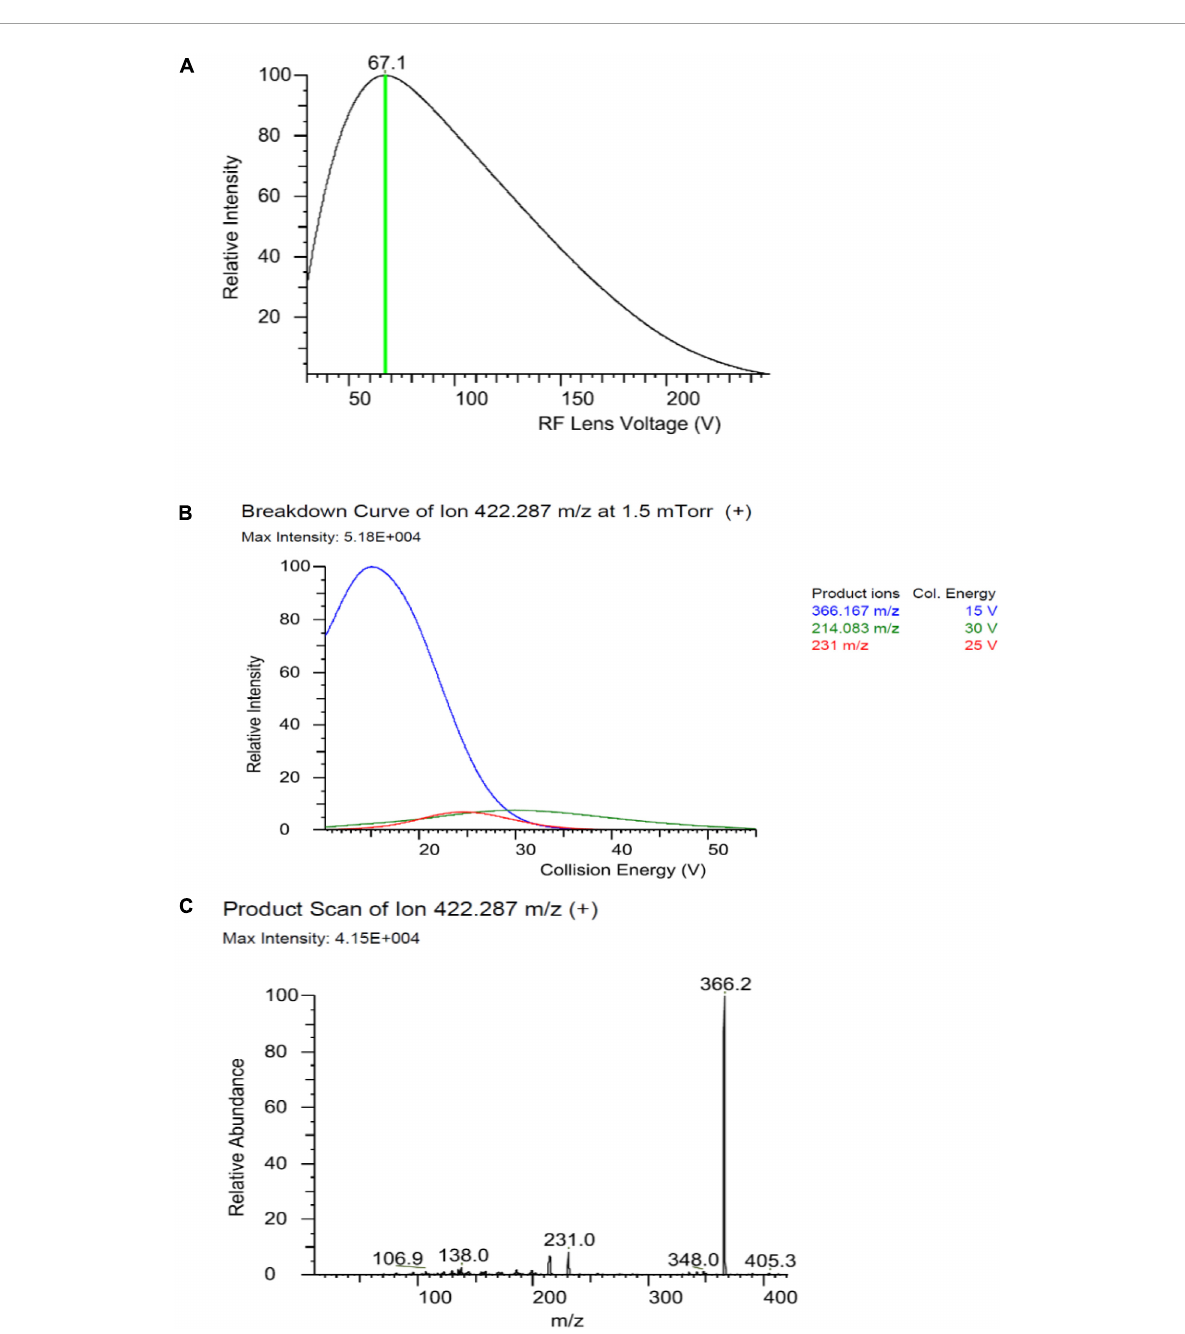
FIGURE2 Optimizing Rf Lens voltage (A) , breakdown curve (B) , and product ion (C) of fenpyroximate precursor ion.